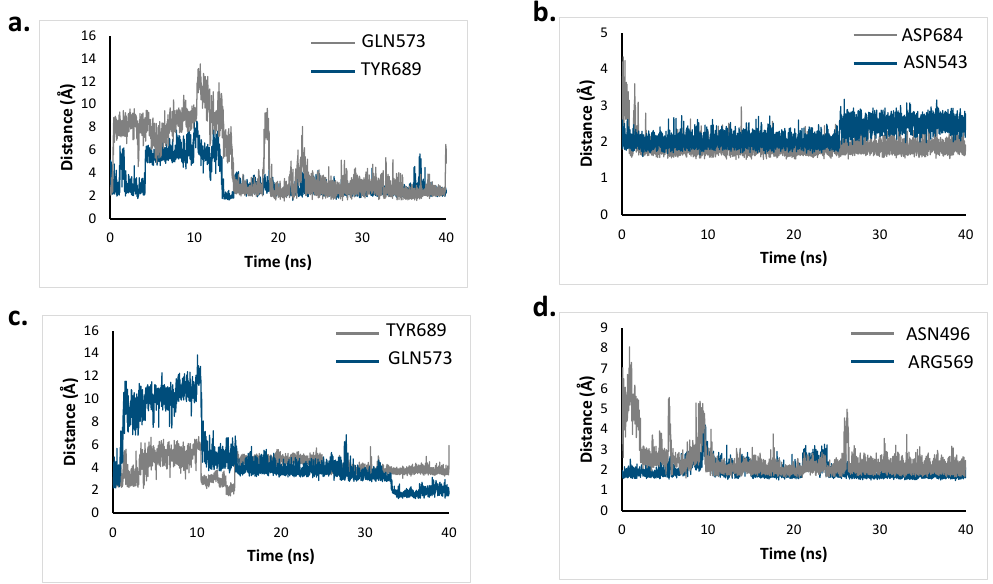
Figure 13. Distance between chloroquine ( a ) digoxin ( b ) dronedarone ( c ) and remdesivir ( d ) with key residues of RdRp.